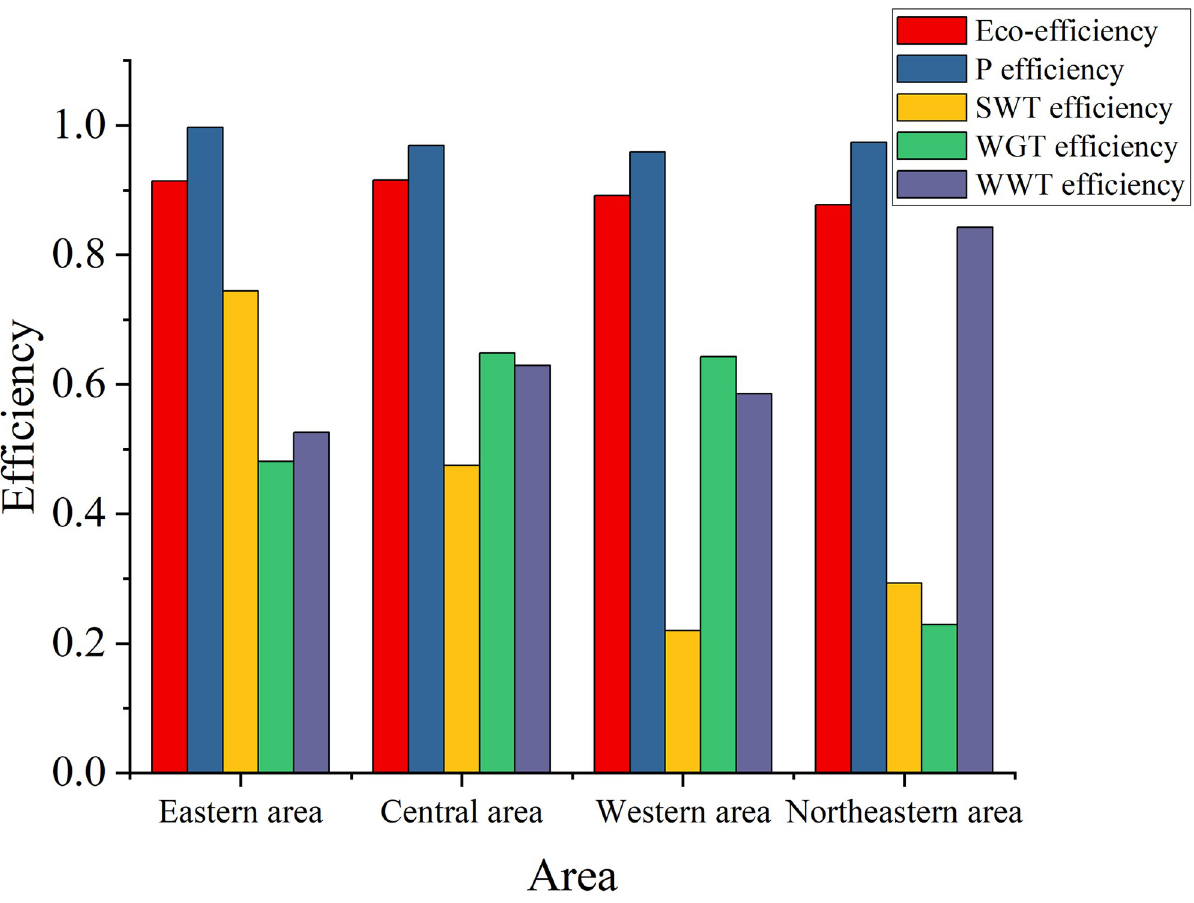
Fig 7. Average eco-efficiency and stage